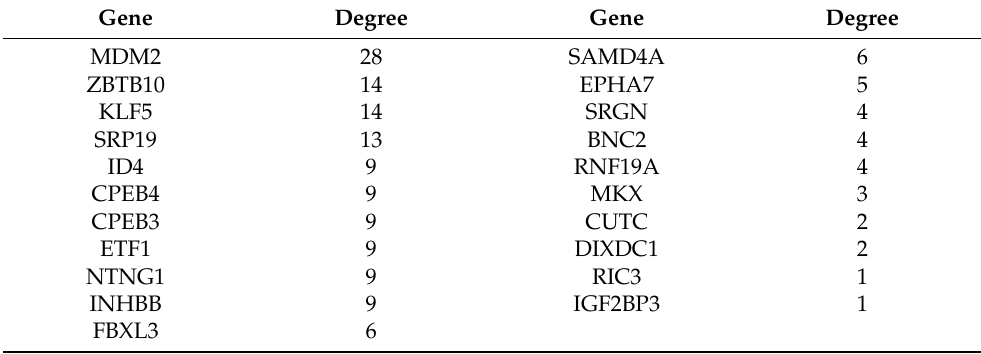
Table 1. Core degree of input genes in PPI